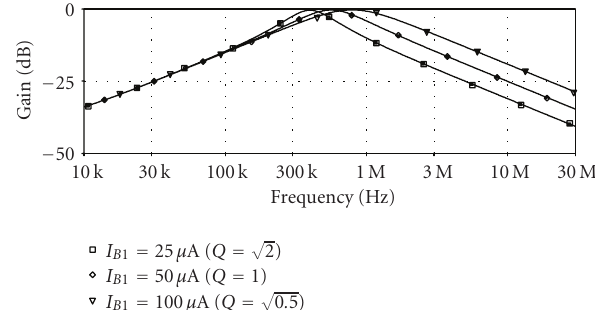
Figure 7: Current-mode bandpass responses for di ff erent values of